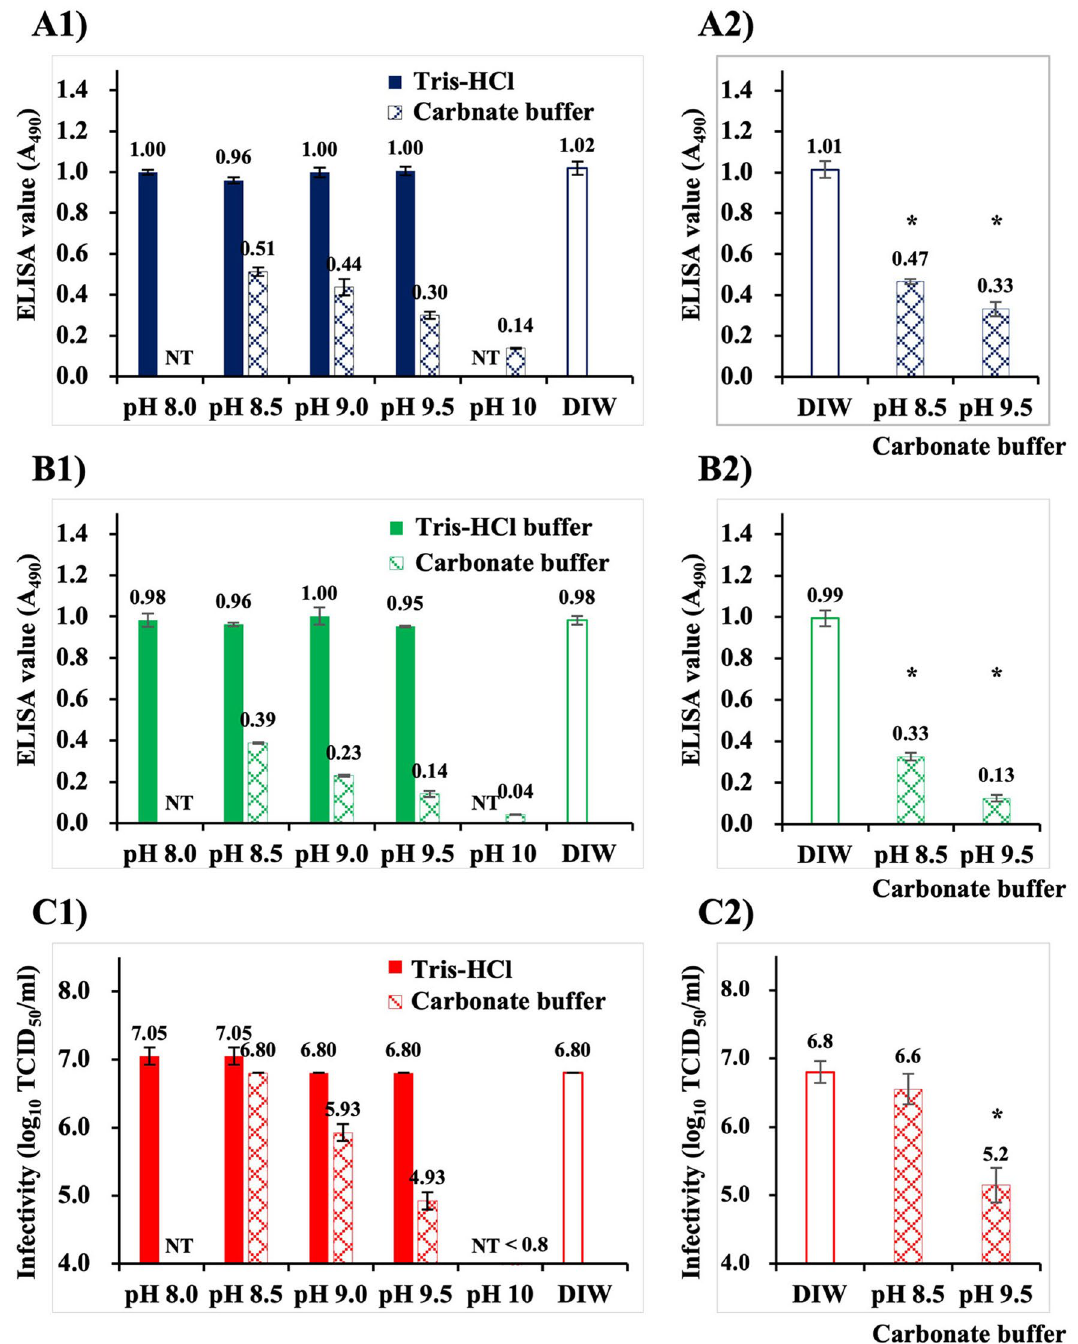
Figure 2. Alteration in antigenicity and infectivity of purified NNV particles after treatment with Tris-HCl or carbonate buffers. Purified NNV particles were treated with 15 mM Tris-HCl buffers (pH 8.0–9.5) or 100 mM carbonate buffers (pH 8.5–10.0) at 25 °C for 24 h. ( A ) Alteration of NNV antigenicity detected with anti- NNV PAb, ( B ) detection with anti-NNV MAb, ( C ) alteration of NNV infectivity. (1) Results of a single set of experiments using the same sample on the same day. (2) The same experiments were conducted five more times on different days, but limited to treatments with carbonate buffers at pH 8.5 and 9.5 and DIW. Error bars indicate SD. *: Significant difference (ρ < 0.05) compared to the values for the DIW treatment. NT: not tested due to out of an effective buffer